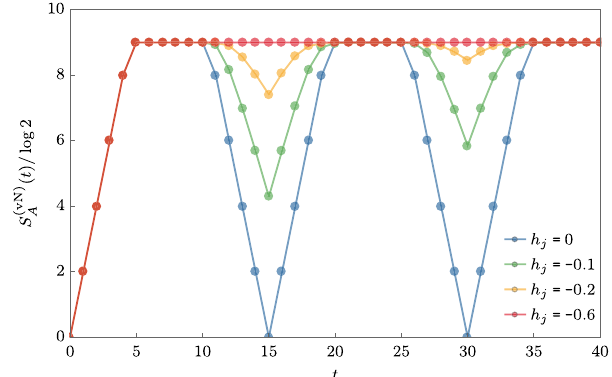
FIG. 9. The von Neumann entropy [cf. Eq. (16)] for a subsystem of N ¼ 9 spins in a kicked Ising system of L ¼ 30 evolving from the separating state with θ different values of the longitudinal magnetic